Question: Identify the chart type used in this figure.
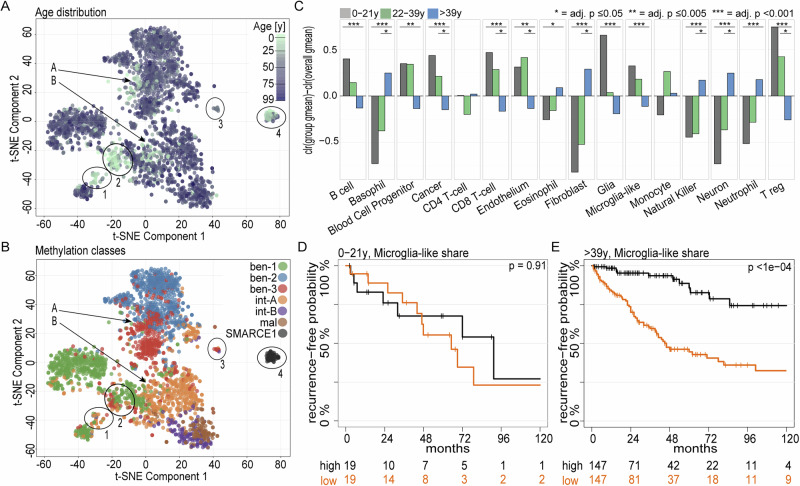
Answer: survival